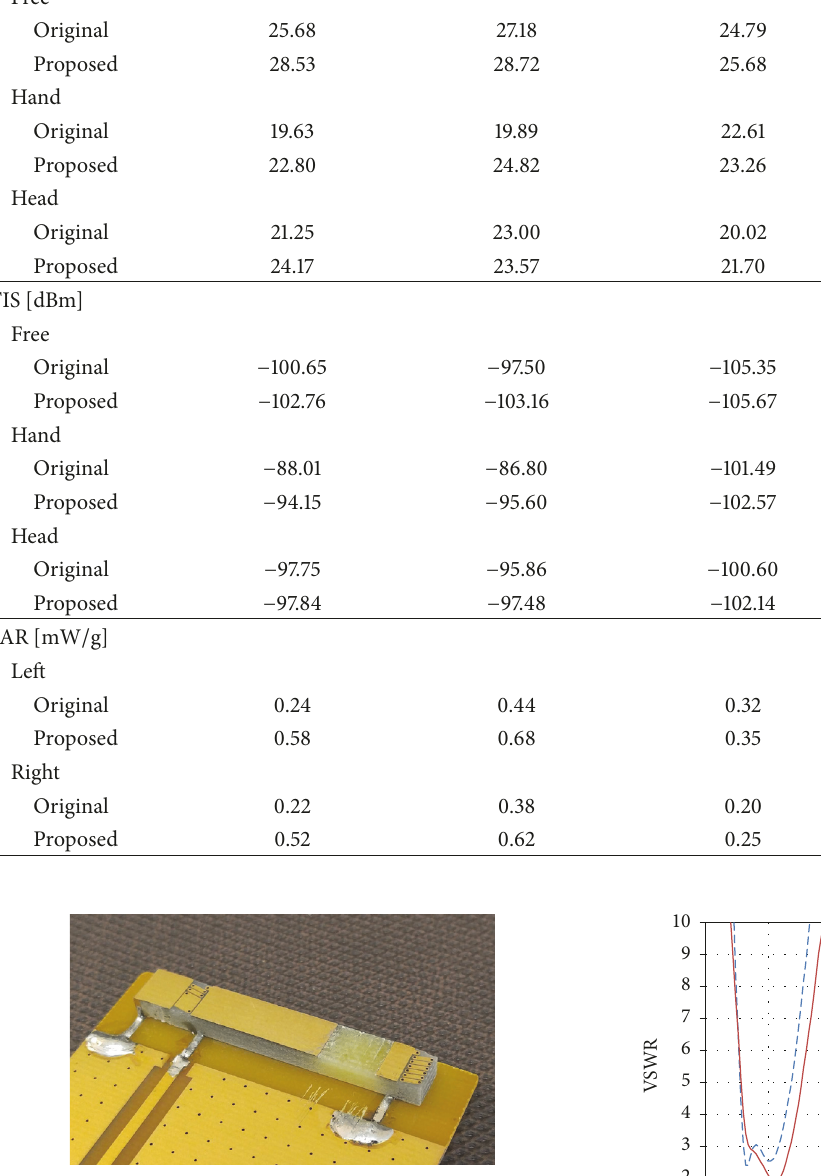
Figure 5: Photograph of the fabricated prototype antenna.